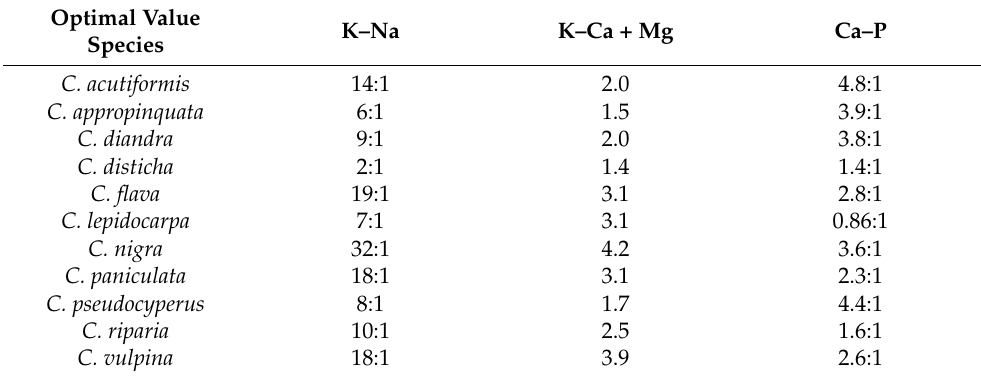
Table 7. Proportion (ratio) of the selected